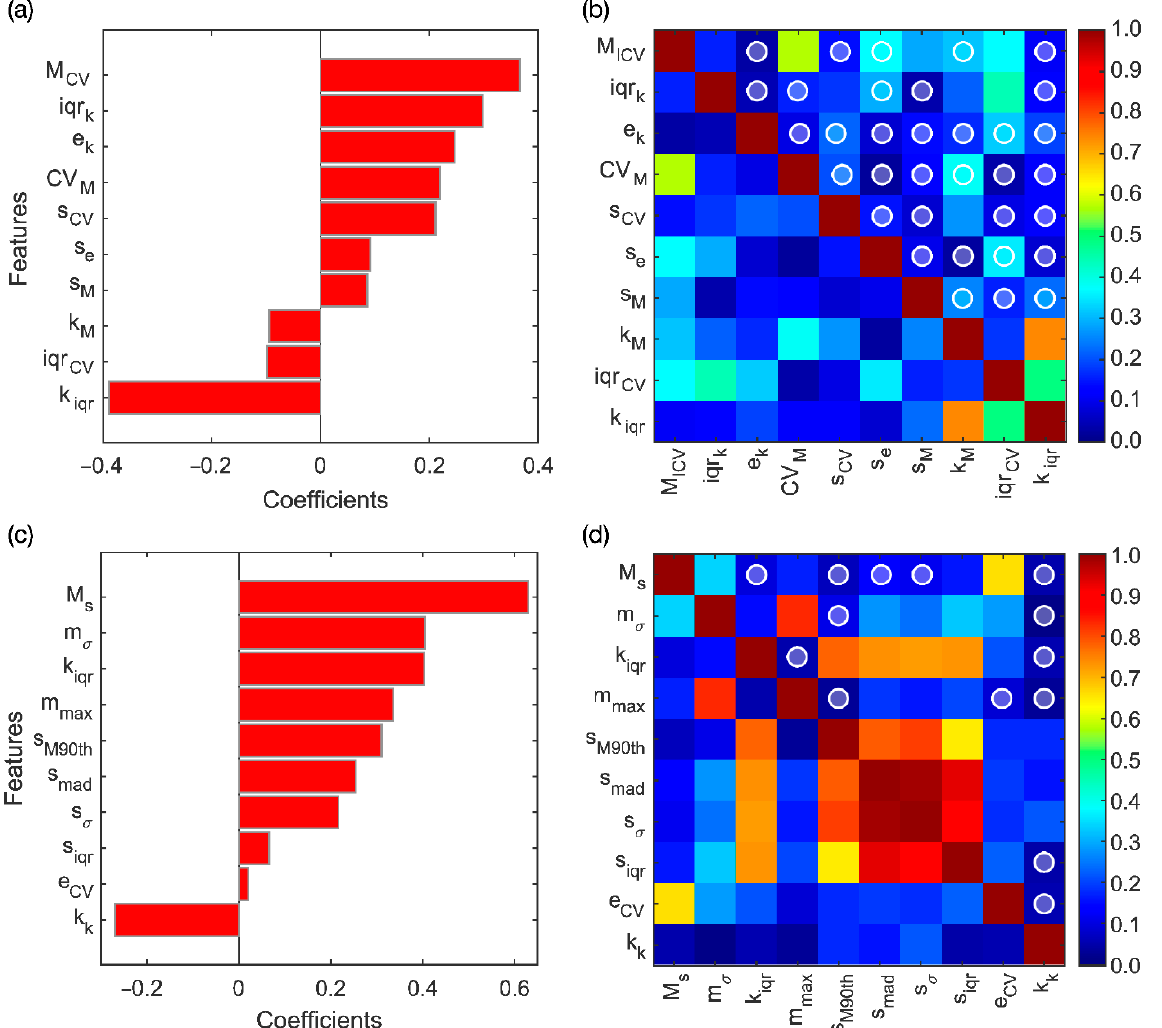
Figure 3. ( a ) Coefficients of the ten RFs selected through LASSO for ADC and ( b ) their correlation matrix. ( c ) Coefficients of the ten RFs selected through LASSO for DWI b2000 and ( d ) their correlation matrix. In ( b , d ), the white circles highlight the uncorrelated couples ( ρ < 0.15).